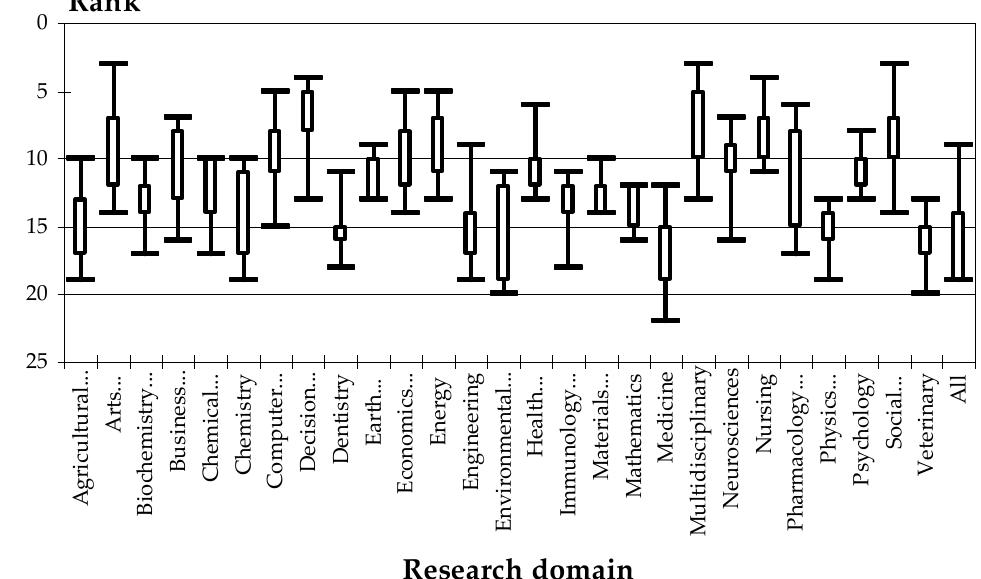
Figure 6. The visibility of articles published in different fields in Poland during 2010–2018, measured based on the adjusted number of citations per document. The figure displays boxplots based on the ranks of the fields computed for each year separately. Results indicate a huge variability and an “average” performance, with relatively steady trends.